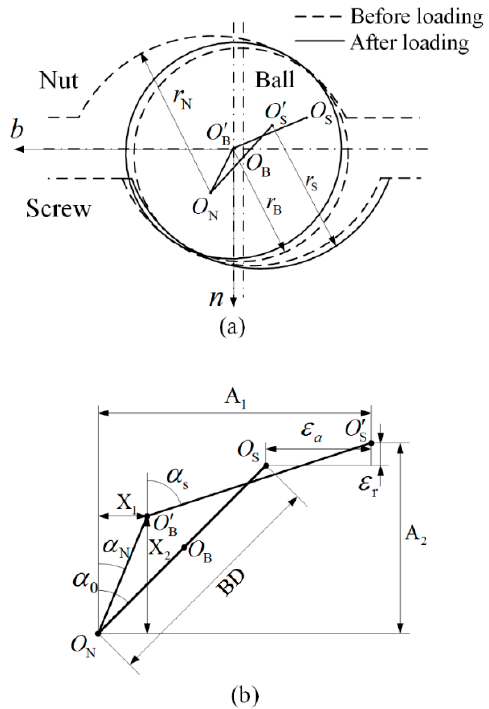
Figure 6. Relative position of curvature center of ball screw before and after loading. ( a ) Position change before and after loading. ( b ) The relative position of the curvature center of the ball and the inner and outer raceways.